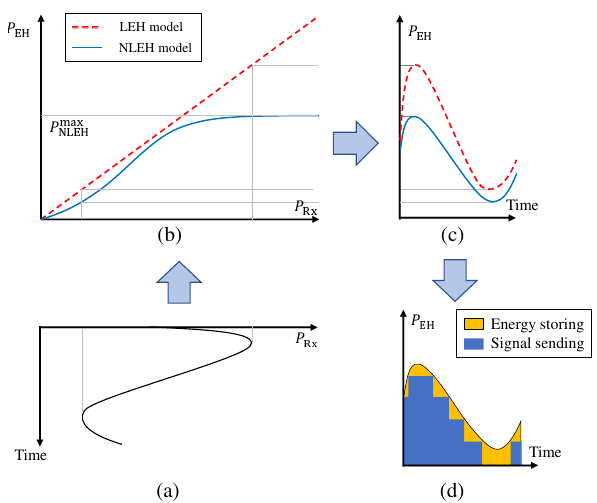
Figure 2. ( a ) The received power at the harvester, ( b ) the LEH and NLEH models, ( c ) the harvested energy and ( d ) the SaT scheme with